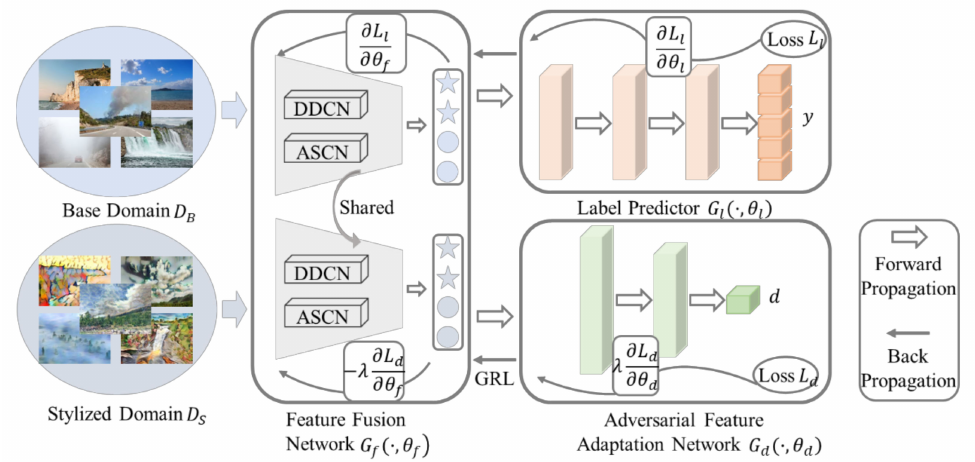
Figure 1. The whole architecture of our